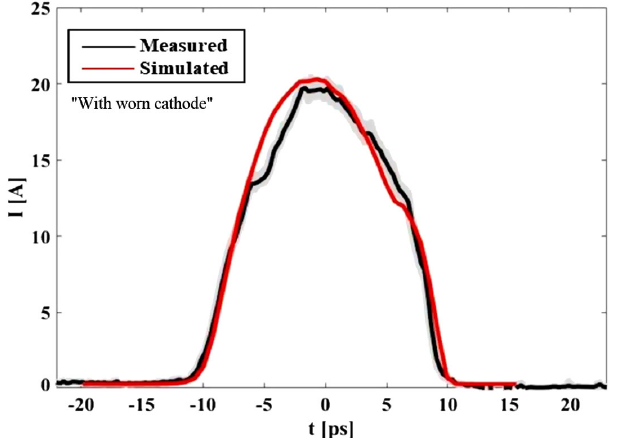
FIG. 17. Comparison of the longitudinal profile between measurement and KRACK 3 simulation for a 250 pC electron bunch at the injector exit. Shading curves represent 5 individual measurements. The black curve stands for the averaged meas- urement data. Note that the bunch head is in the direction of negative t, and that, the bunch tail is towards the opposite direction where t is positive. The head-tail orientation is the same between measurement and simulation.